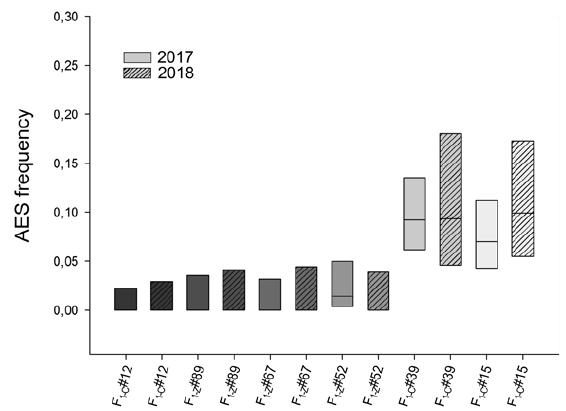
Figure 3. Apospory expressivity in diploid individuals of P. rufum measured during two annual periods in Zavalla. The frequency of ovaries containing AES (box middle line) scored in each plant is plotted together with 95% confidence intervals (CI). Boxes colored with different shades of grey indicate different genotypes; plain boxes represent measurements made during 2017, while striped boxes represent measurements made during 2018. No significant differences were detected between the two years.